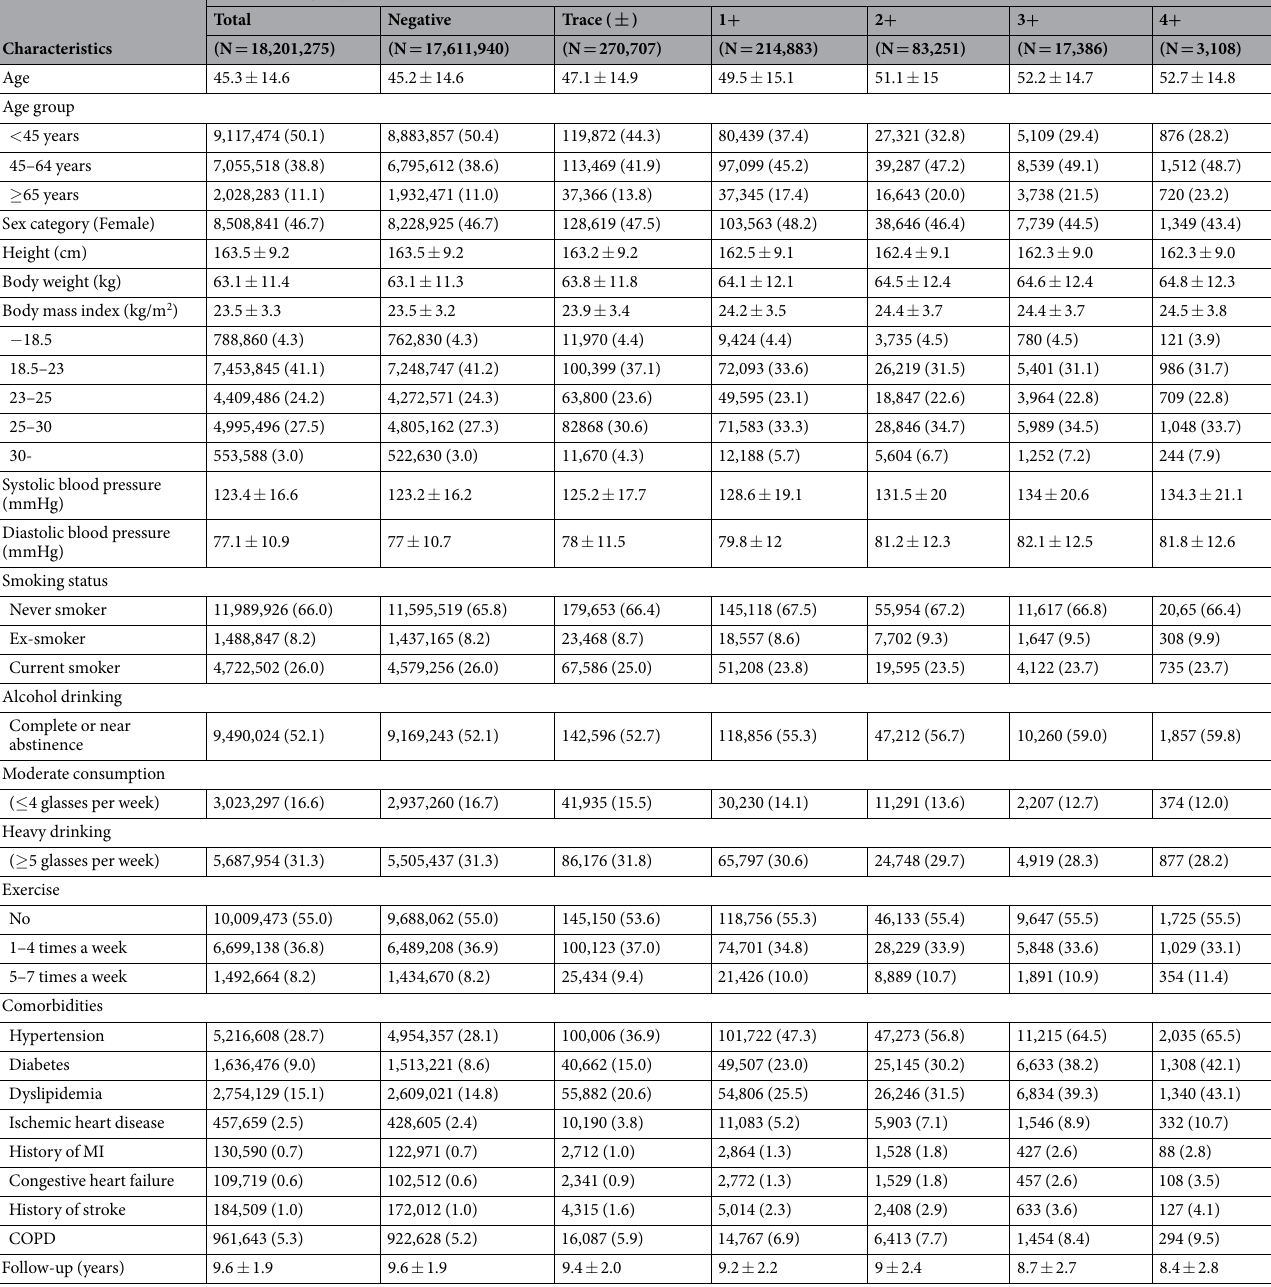
Table 1. Baseline characteristics of the study population. Values are n (%) or mean ± SD. COPD, chronic obstructive pulmonary disease; MI, myocardial